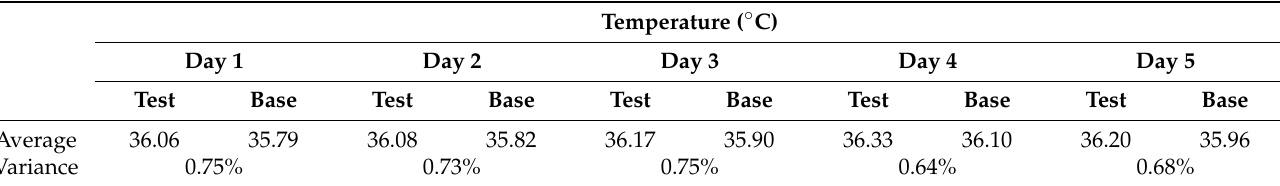
Table 2. Comparison of test and base readings.